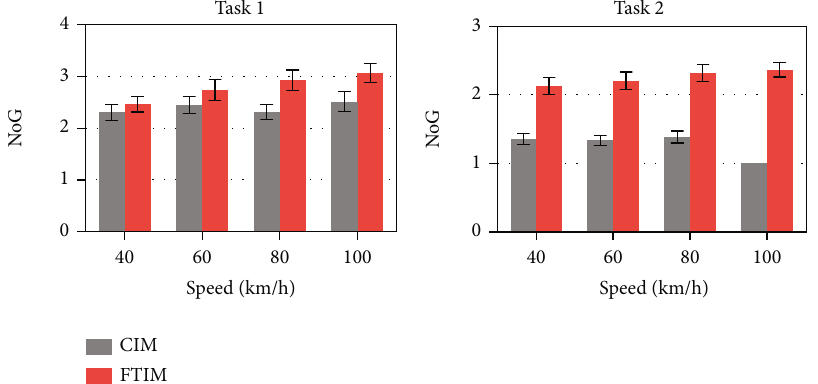
Figure 9: NoG for two tasks by interaction mode and vehicle